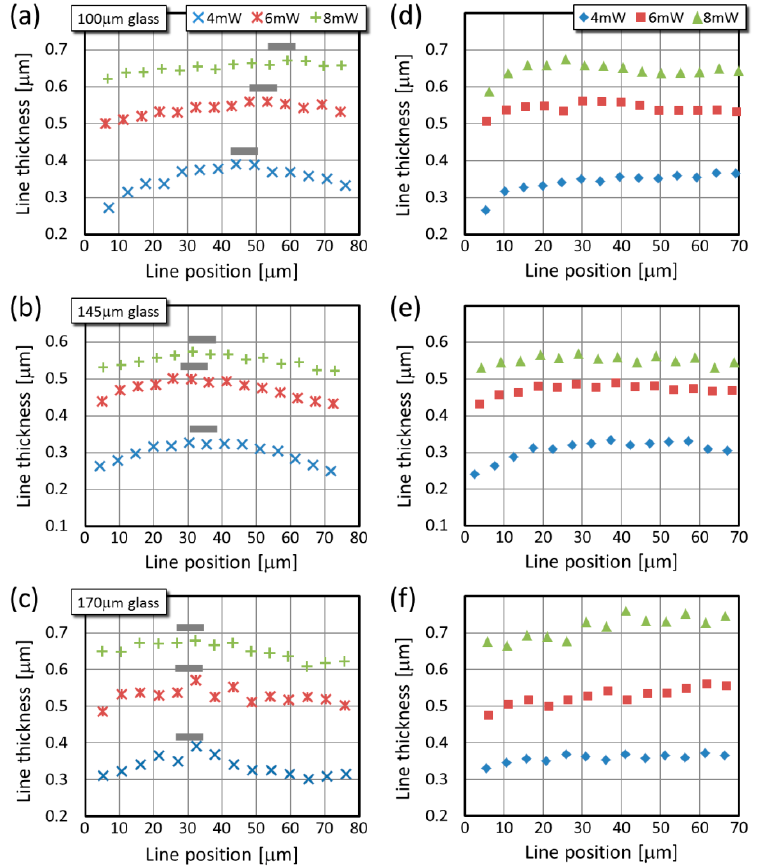
Figure 4. Typical line thickness values as the function of the position over the glass surface for three glass sizes. Panels ( a – c ) are from uncorrected lines, while panels ( d – f ) are from SA-corrected ones. The grey lines show the approximate positions of the maxima.